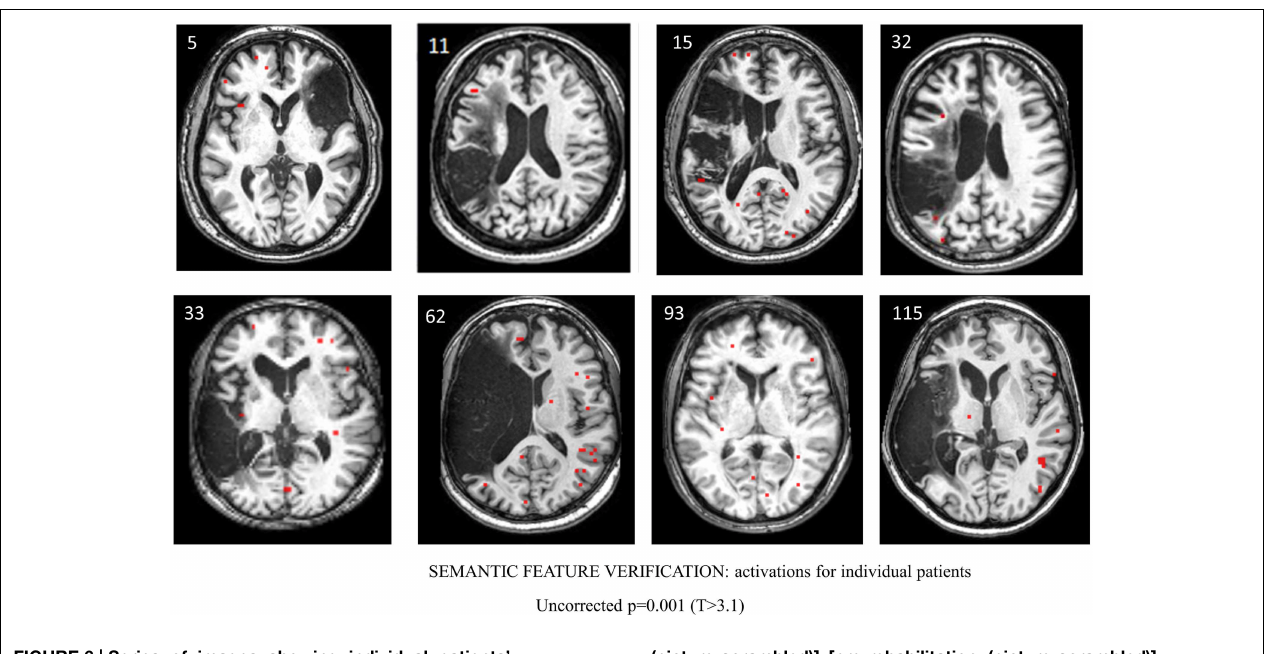
FIGURE 6 | Series of images showing individual patients’ activation maps for the semantic feature verification task illustrating the [post-rehabilitation